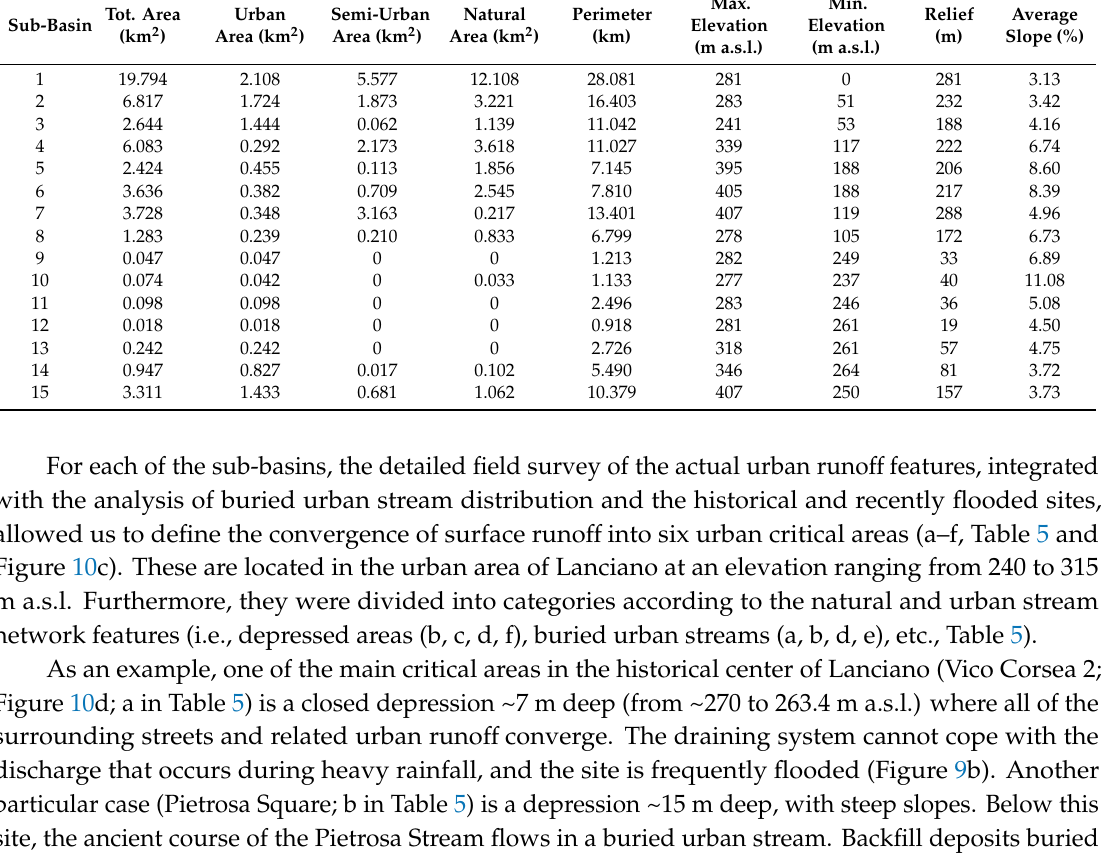
Table 4. Main morphometric parameters of the 15 sub-basins in the study area. Tot. Area Sub-Basin (km 2